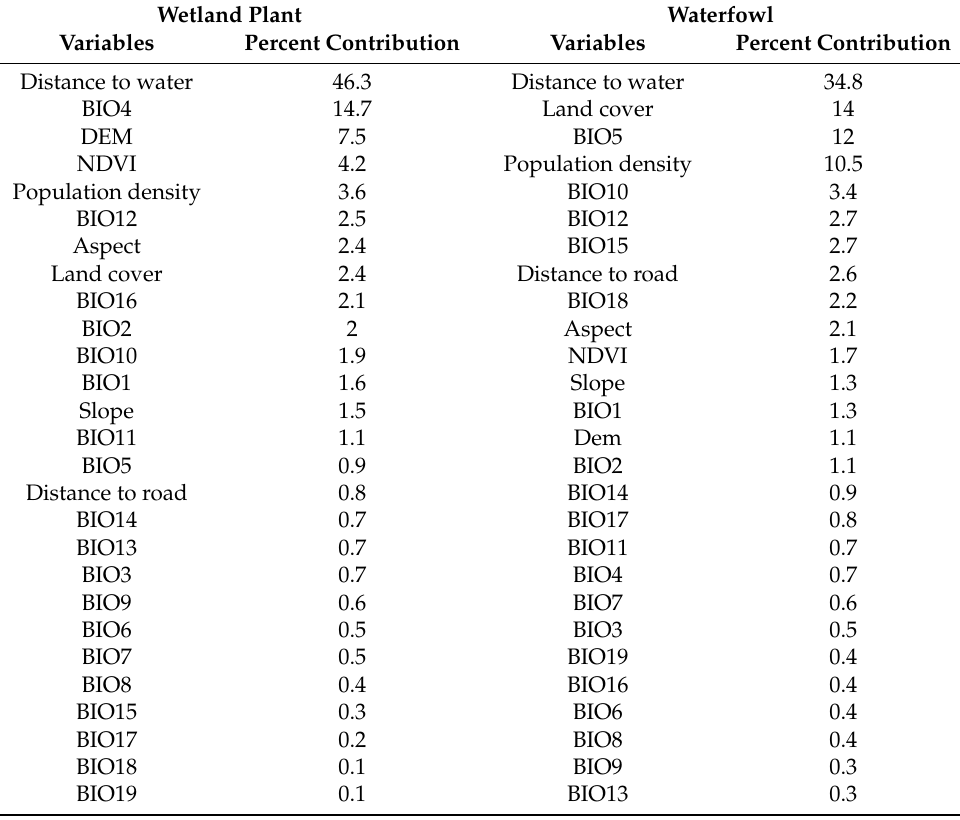
Table A2. Raster plot of all variables involved in the model